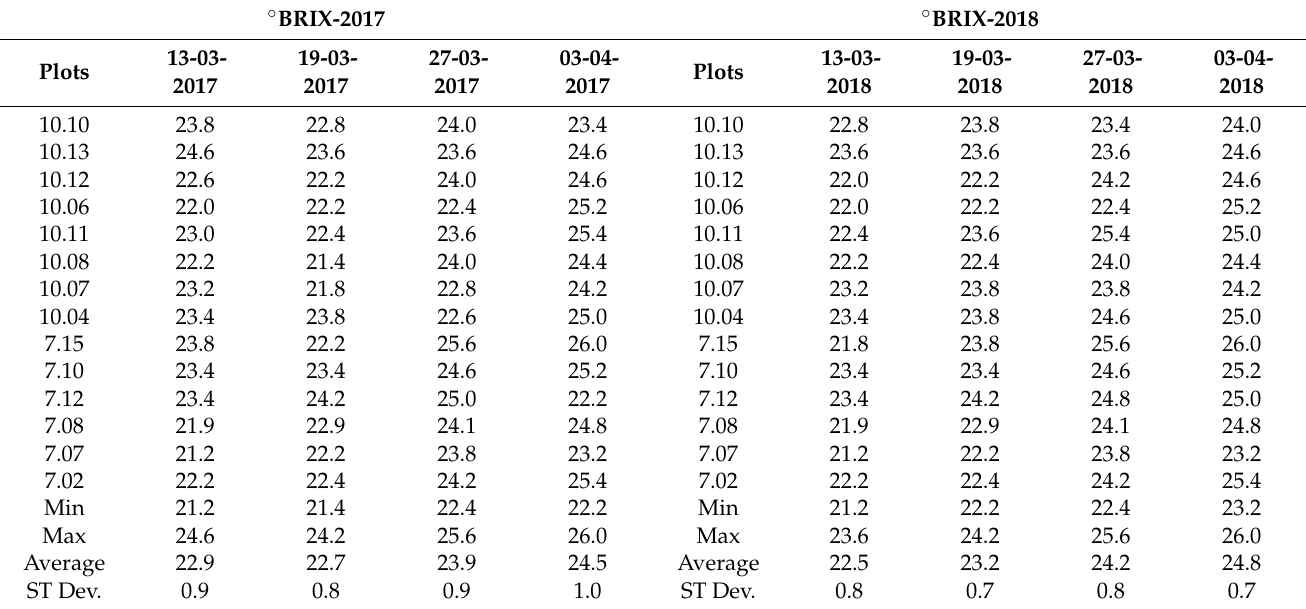
Table 1. ◦ Brix field sampling values.